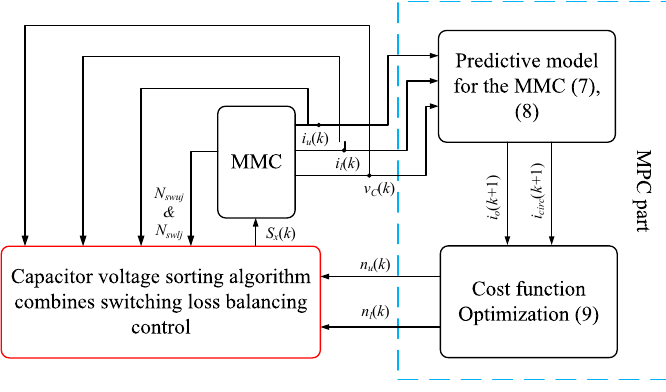
Figure 5. Control structure of proposed approach.